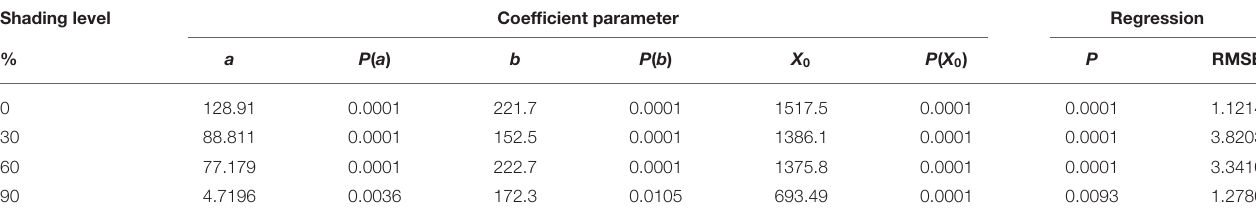
TABLE 4 | The coefficient of three parameters log-logistic equation fitted to describe the effect of shade levels of Parthenium hysterophorus on final plant height. Shading level Coefficient parameter Regression